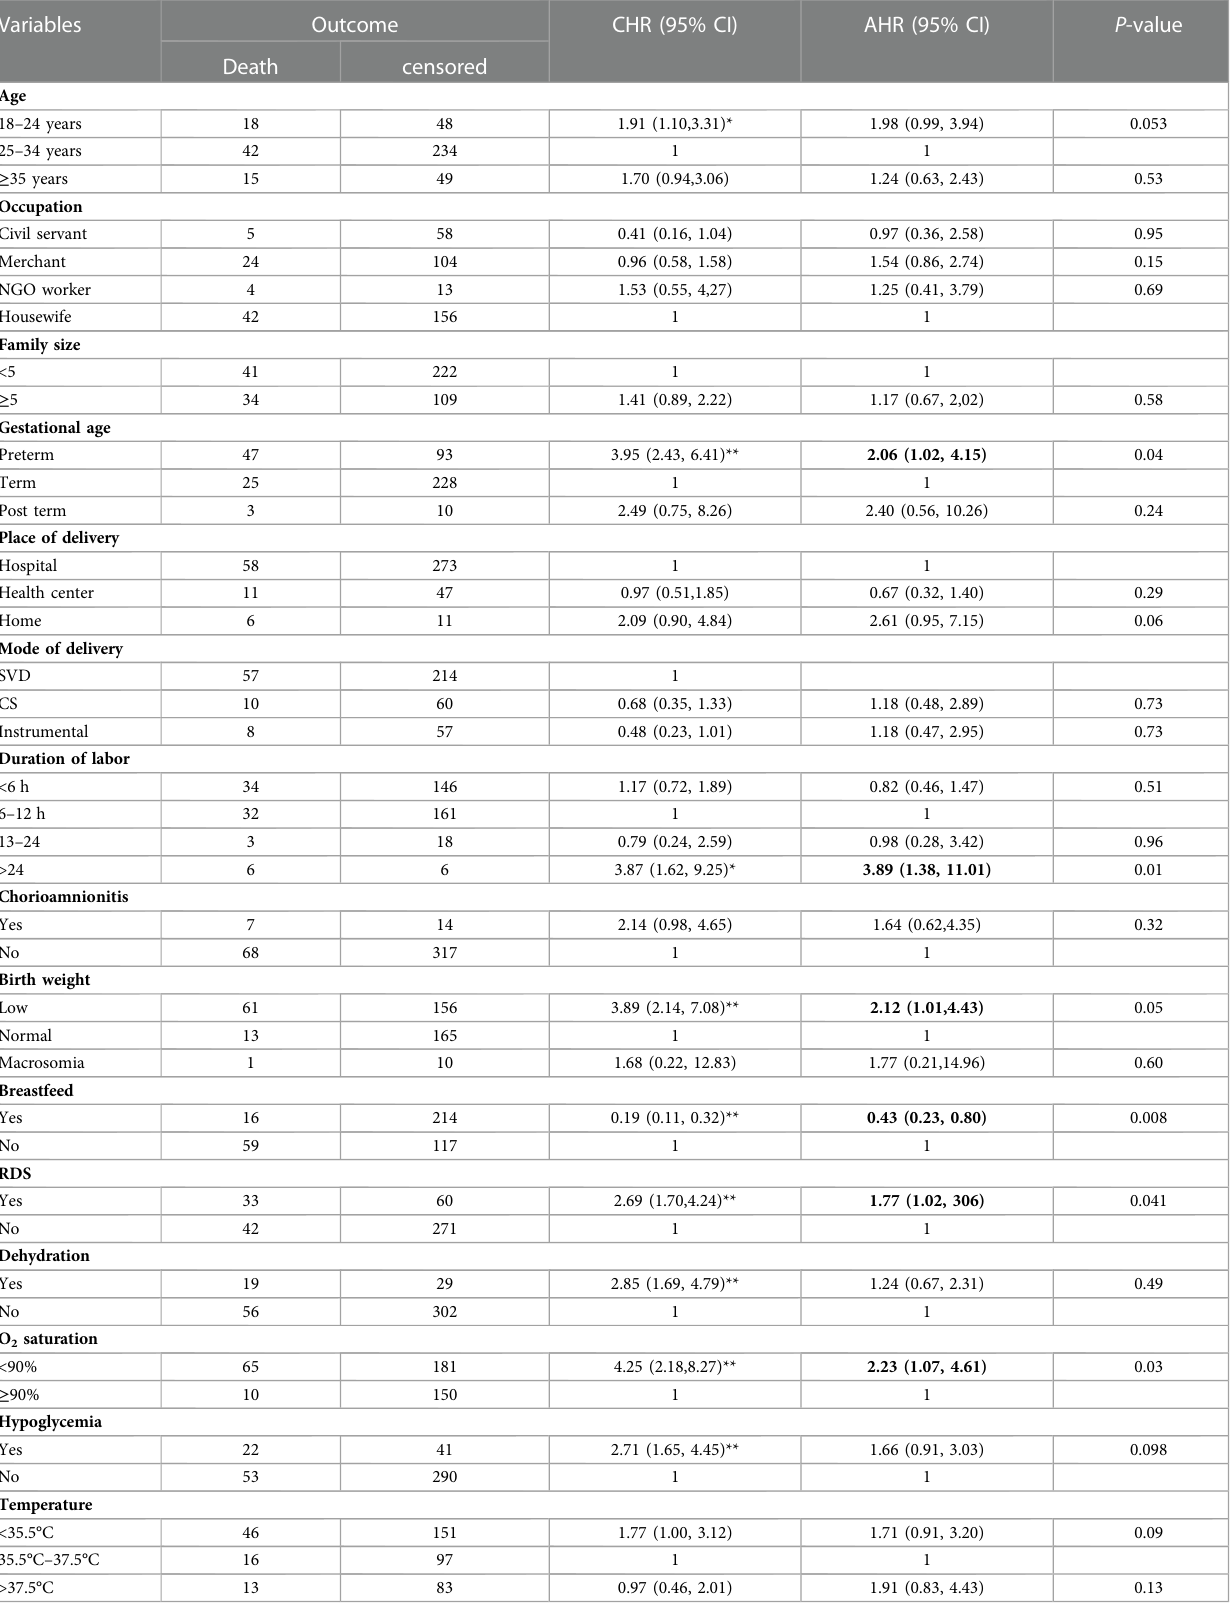
TABLE 4 Predictors of death among neonates admitted with neonatal sepsis at NICU of northwest Ethiopia referral hospitals, 2021. Variables